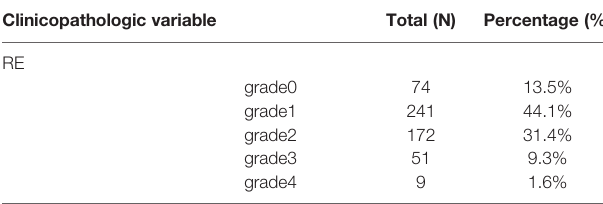
TABLE 1 | Characteristics of locally advanced ESCC patients enrolled in this study (n =